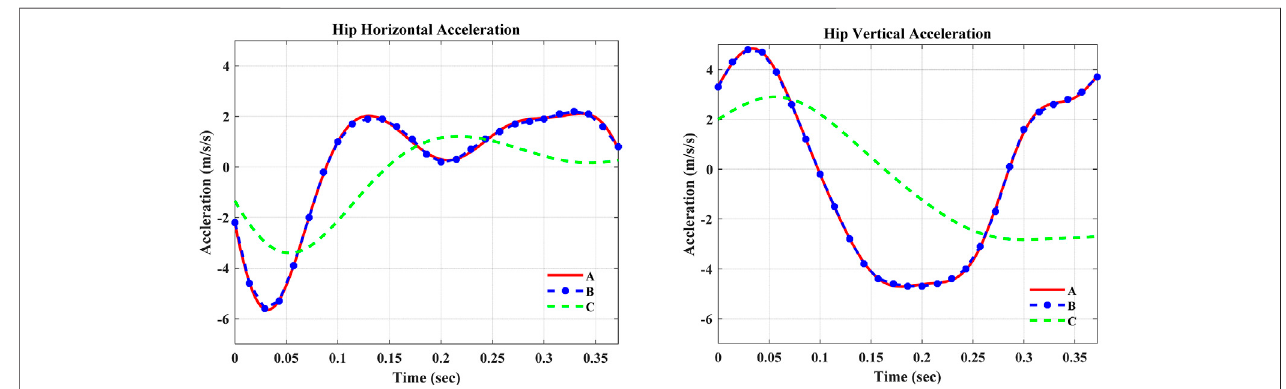
FIGURE 8 | Curve- fi tted and scaled data of hip acceleration. In the fi gures, A — Curve- fi tted data (without scaling), B — Experimental data from Winter (2009), and C — Curve- fi tted data with 60% amplitude and frequency scaling.